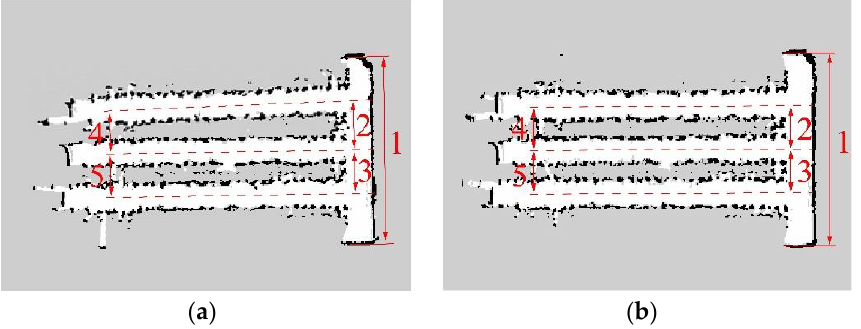
Figure 4. Greenhouse mapping with different combinations of sensors. ( a ) IMU/ODOM/LIDAR. ( b ) UWB/IMU/ODOM/LIDAR.